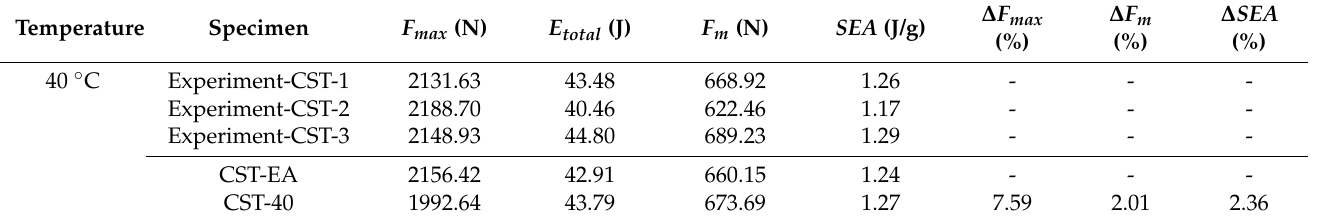
Figure 6. Comparison of experimental and simulated force-displacement curves for CST at 40 °C.